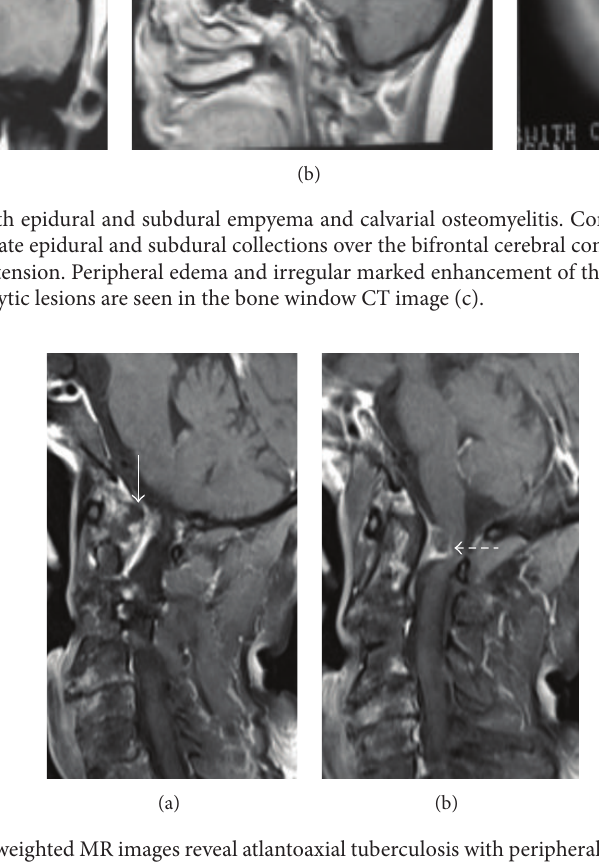
Figure 9: Postcontrast sagittal T1-weighted MR images reveal atlantoaxial tuberculosis with peripherally enhancing epidural abscess ( arrow ) accompanied by cord compression ( dashed arrow ) in a 62-year-old female who presented with gradual bilateral